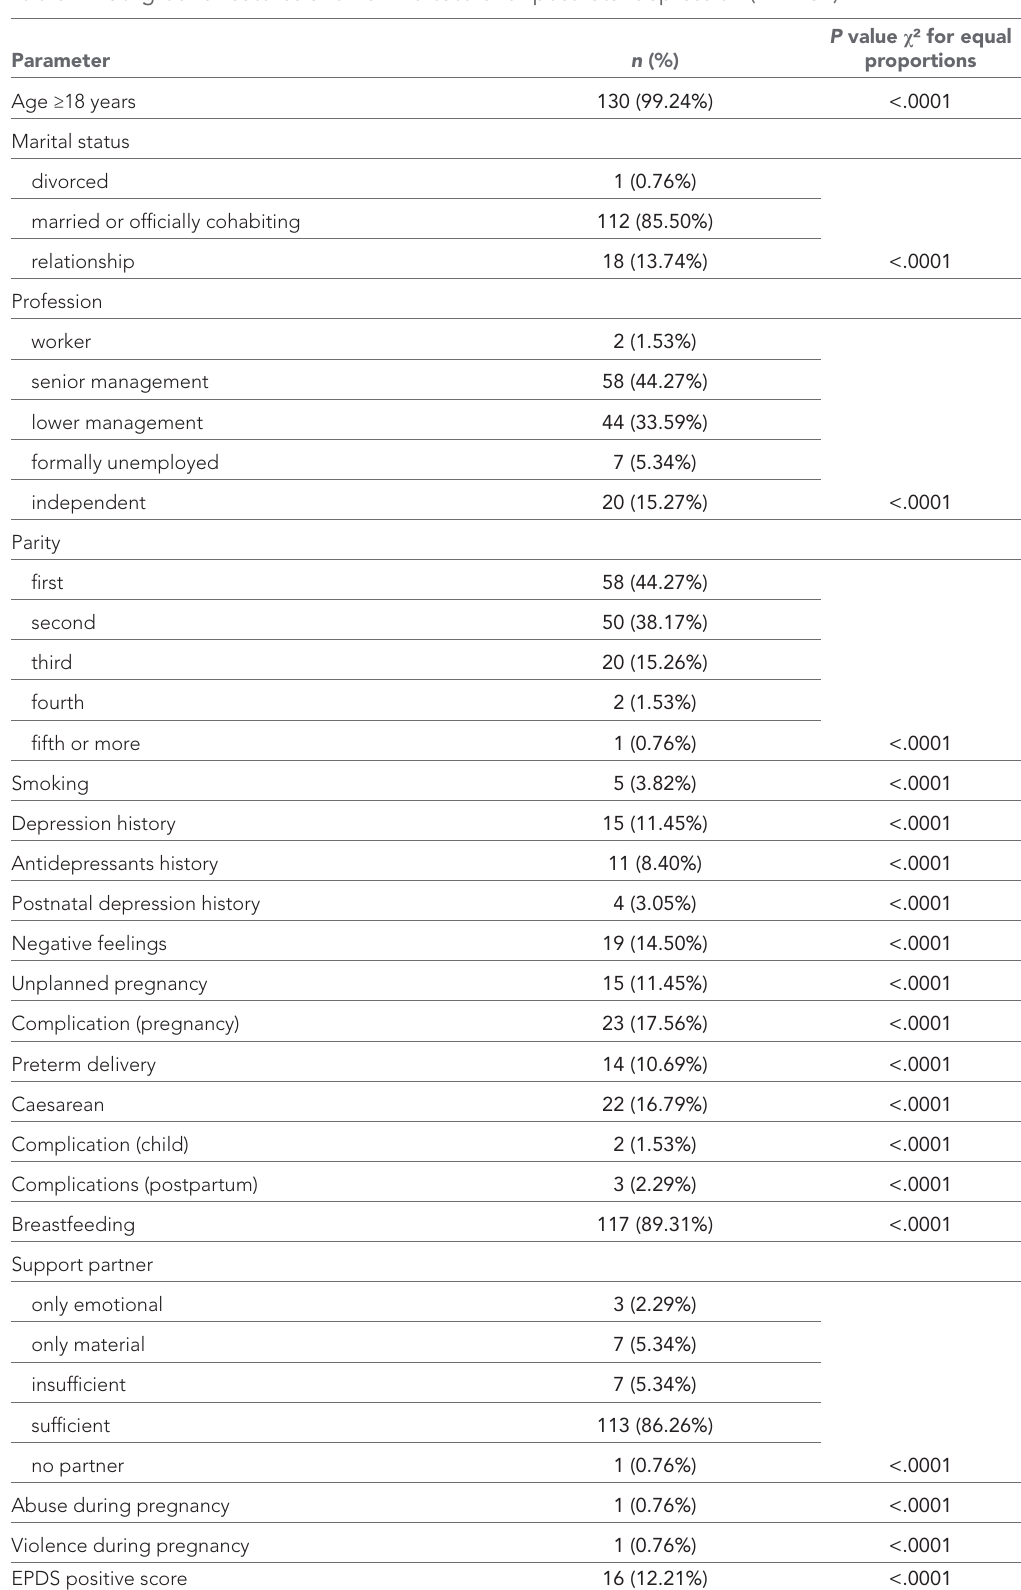
Table 1 Background features and risk indicators for postnatal depression ( n = 131)